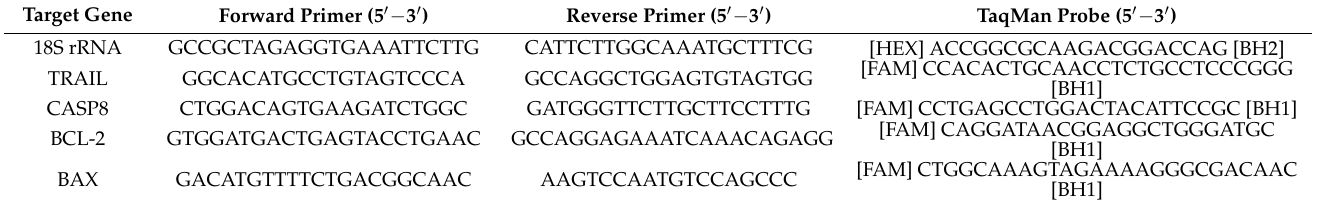
Table 1. Primer and probe sequences of related genes for quantitative polymerase chain reaction